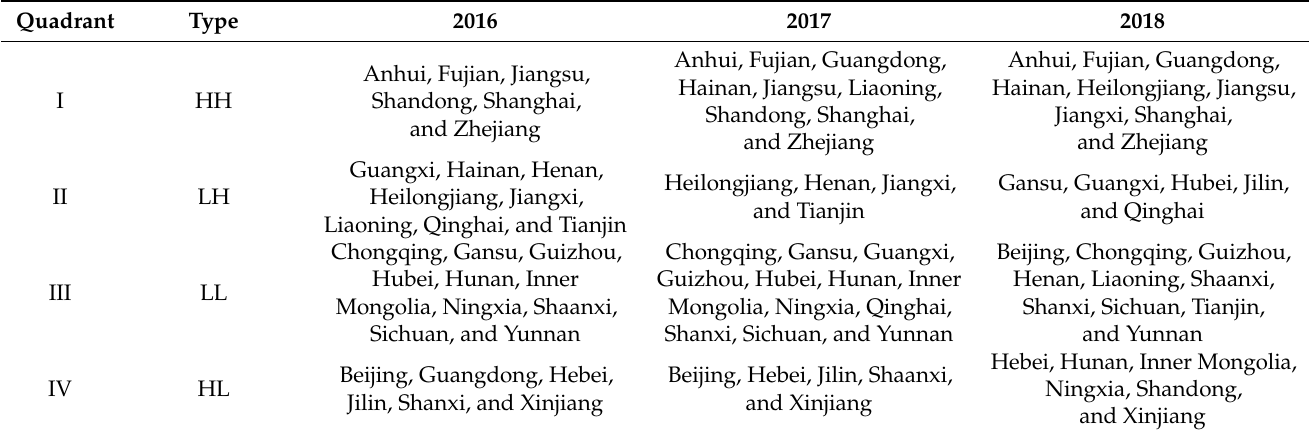
Table 3. Quadrant distribution of Moran’s I index of the PPP rate (source: authors’ calculations).